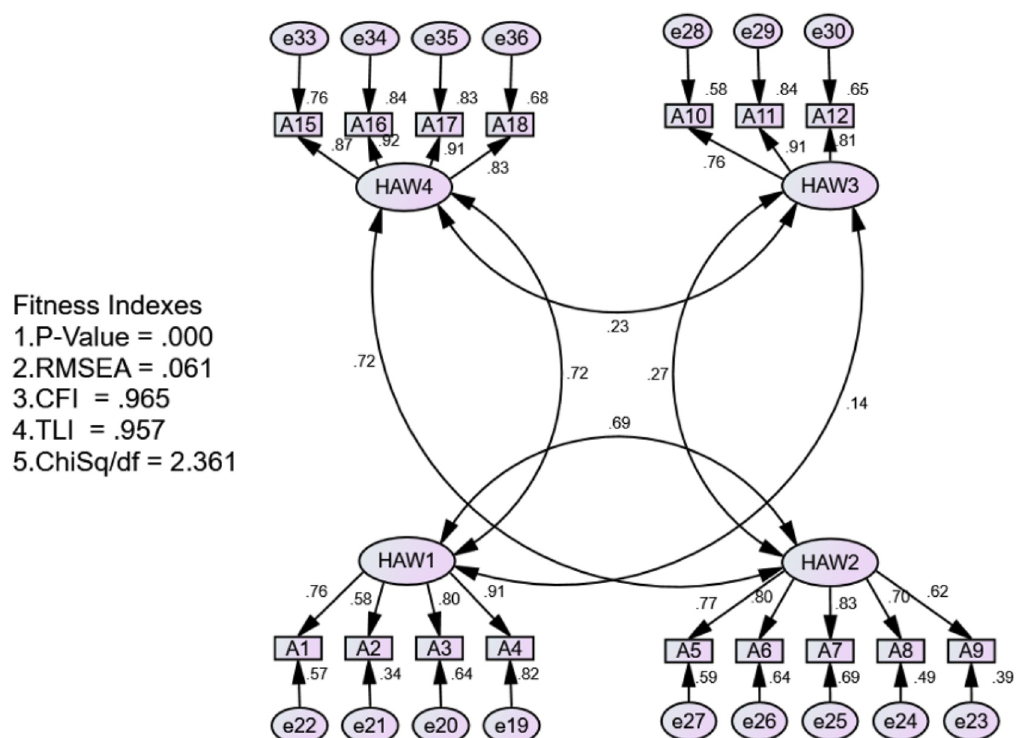
Fig 2. The results of discriminant validity for